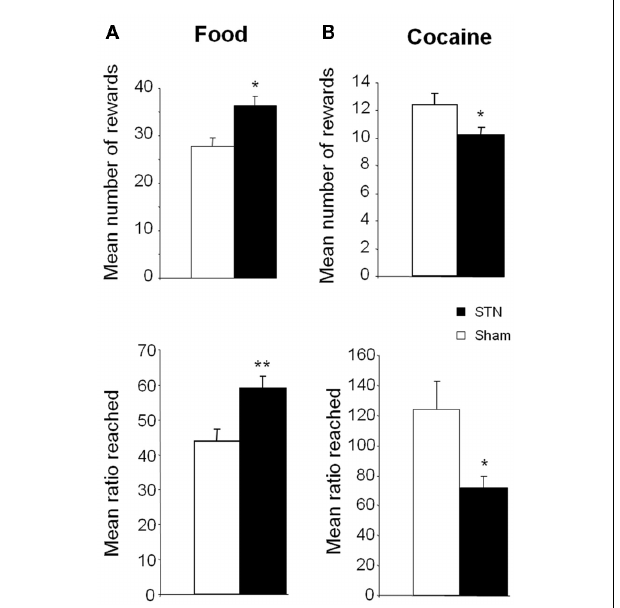
FIGURE 4 | Effects of bilateral high frequency stimulation (HFS) of the STN on motivation to work for either food (A) or intravenous cocaine (B) in control [OFF stimulation (empty bars)] and stimulated rats (black bars) performing a progressive ratio schedule of reinforcement. Rats were required to produce an increasing number of lever presses to obtain the given reward.The number of rewards obtained is illustrated on the upper part of the graph, while the last ratio reached is illustrated on the lower part. (taken from Rouaud et al., 2010).Vertical bar: SEM. *** p < 0.05 and p < 0.01 respectively compared with control group (OFF stimulation